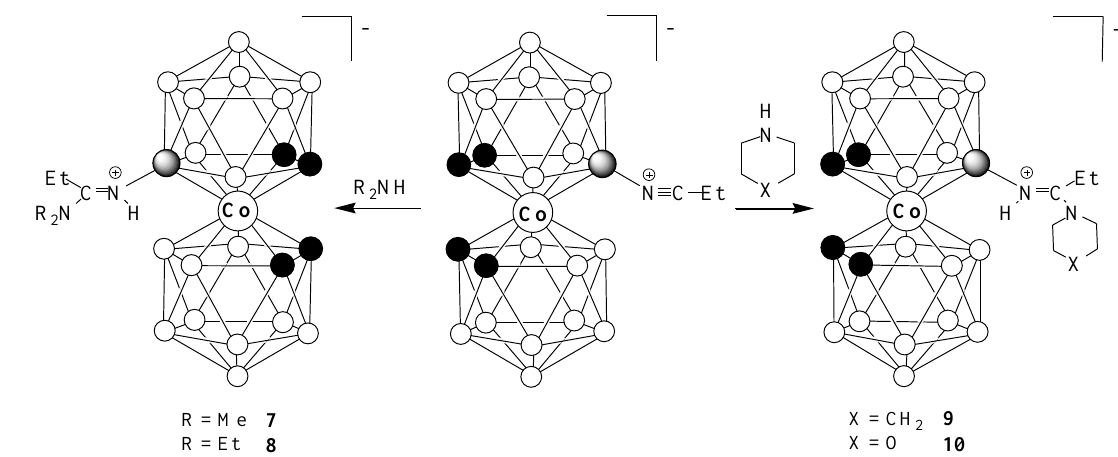
Figure 2. ( HH)NOESY NMR spectrum of amidine 8 in acetone-d 6 with diagonal peak suppression.